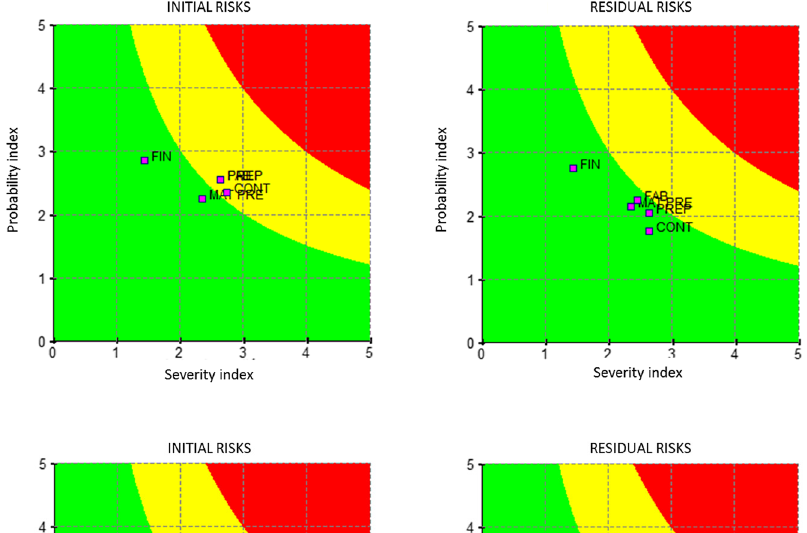
Figure 4: Farmer ’ s diagram of initial and residual risks by danger for PRA1.